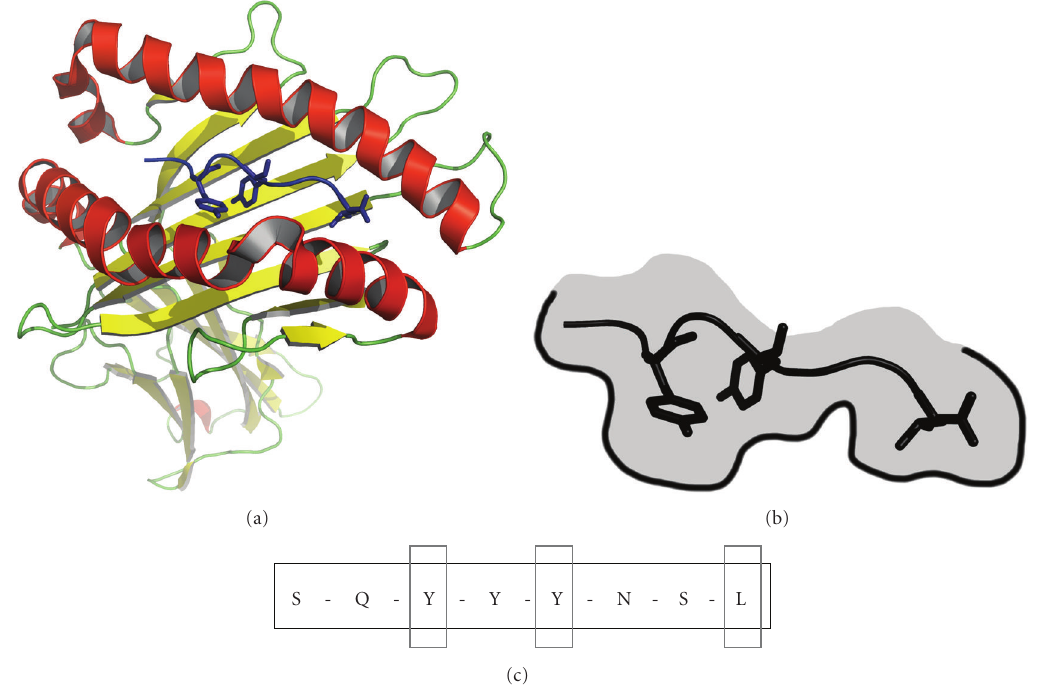
Figure 1: Structural model of murine MHC I molecule H2-K b with bound octapeptide SQYYYNSL . (a) Crystal structure model of H2-K b with bound octapeptide SQYYYNSL (PDB entry 2clv [33]). Top view of the peptide binding groove: red : alpha helices; yellow : beta sheets; blue : octapeptide SQYYYNSL , amino acids of the anchor positions are shown as sticks. (b) Schematic side view of the peptide binding groove with the bound octapeptide SQYYYNSL ; Amino acid side chains at the anchor positions are shown as sticks. (c) The octapeptide SQYYYNSL with boxed anchor positions of the canonical